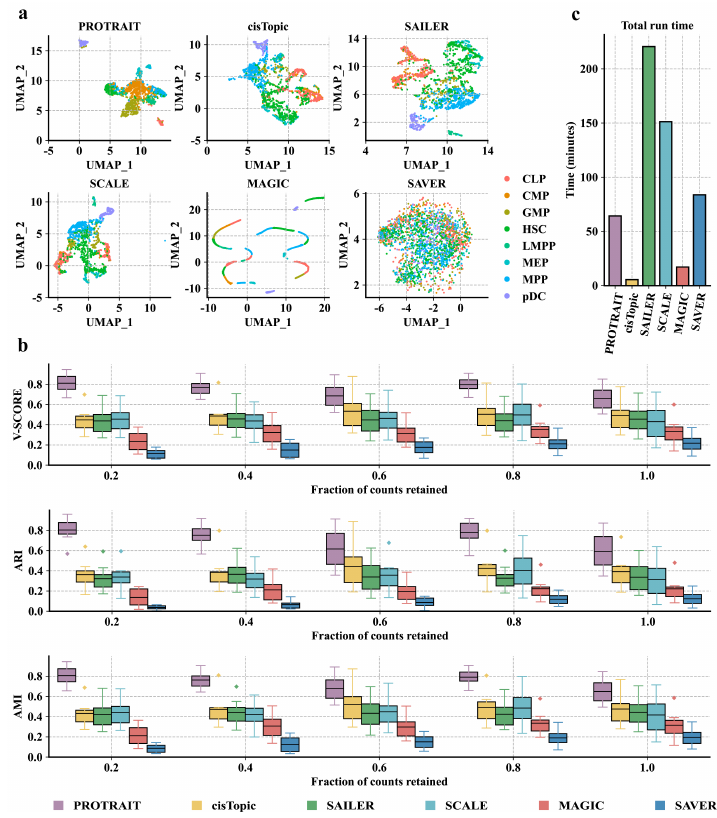
Figure 3. Performance of diverse cell representation approaches compared by cell type annotation. ( a ) UMAP representation of the cell embeddings derived from PROTRAIT, cisTopic, SAILER, SCALE, MAGIC, and SAVER. All approaches are trained on the full dataset. ( b ) The average v -score, ARI, and AMI for each cell type are measured after clustering based on the cell embeddings. All approaches are trained on the datasets where the total number of peaks per cell remains at 20%, 40%, 60%, 80%, and 100% of the total peaks, respectively. ( c ) Runtimes for each of the cell-embedding approaches profiled. All approaches are trained on the full